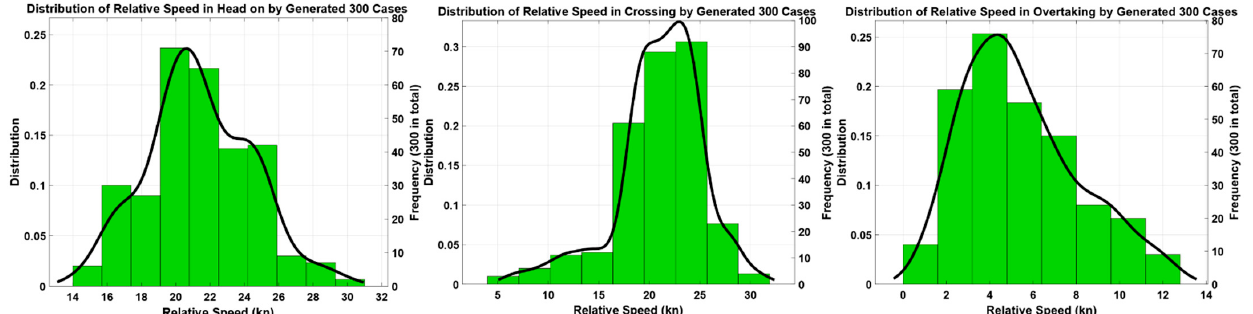
Figure 13. Distributions of initial relative speed for the 900 (300 each encounter) virtual scenario cases